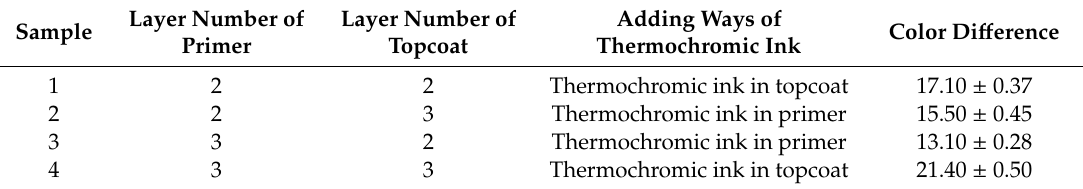
Figure 4. The color di ff erence change of waterborne coating on Chinese fir from 18 to 40 ◦ C. Table 3. Orthogonal experimental result of the influence of coating processes on the color di ff erence of